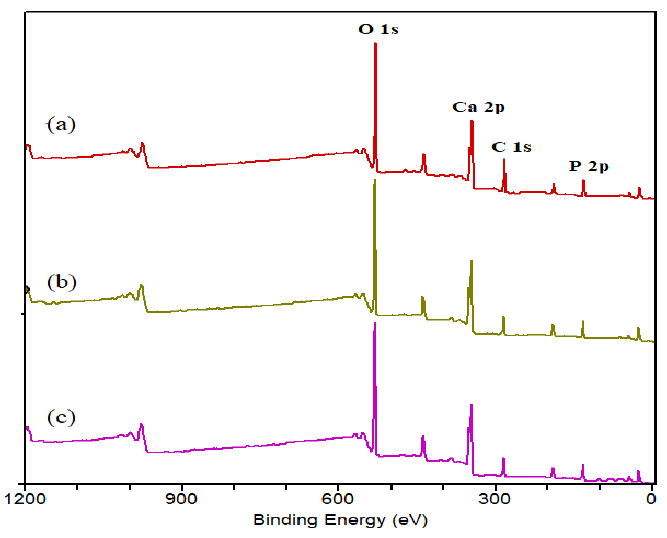
Figure 8. XPS spectra of ( a ) HAp-D, ( b ) HAp-S, and ( c ) HAp-R. As shown in Figure 9, for HAp-D and HAp-S, a well-defined doublet with two components Ca 2p 1/2 (347.4 eV) and Ca 2p 3/2 (350.9 eV) is observed, which is attributed to Ca involved in bonds characteristic of HAps [30,35]. However, the Ca 2p spectrum of HAp-R suggests that the environment of Ca ions on the surface of HAp-R is not similar to that in HAp-S and HAp-D.